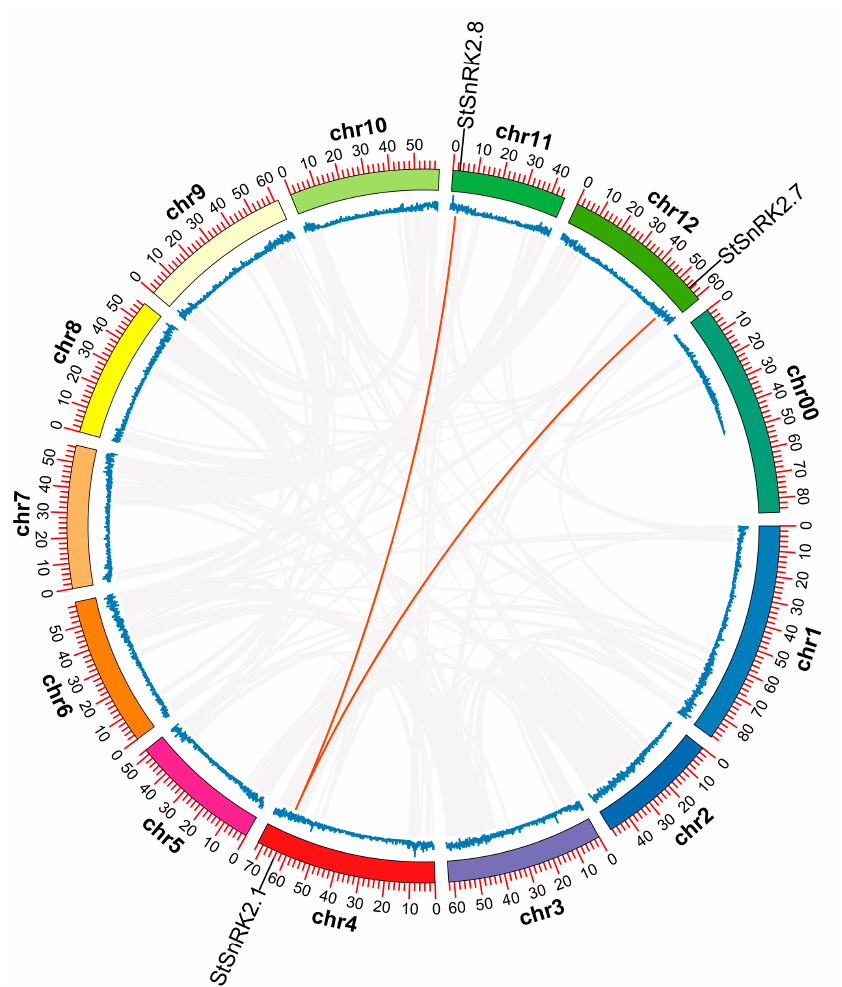
Figure 3. The relationship between chromosomes of StSnRK2 from potato was determined using multiple collinear scanning toolkits (MCScanX) was visualized using TBtools v1.098669. Gray lines represent the collinear blocks within the potato genome, whereas the red lines highlight the syntenic SnRK2 gene pairs. The height and position of the blue wave peak represent the number and distribution of genes on each chromosome,